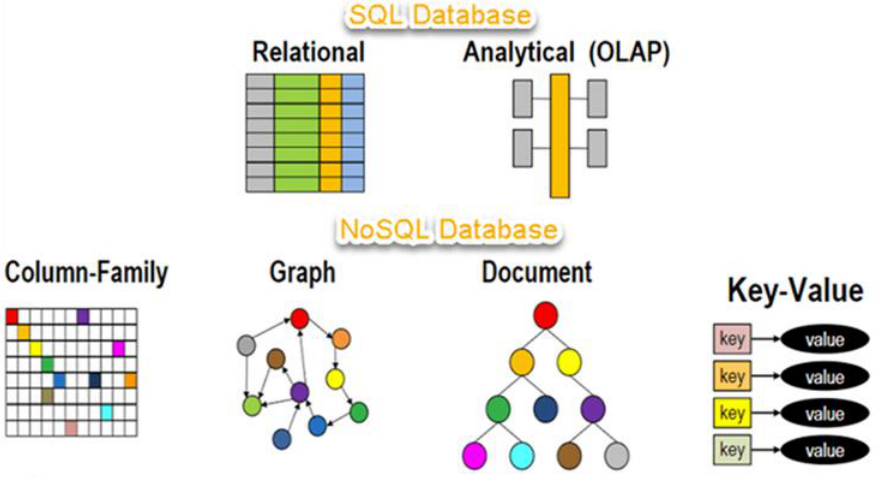
Figure 3. SQL vs. NoSQL